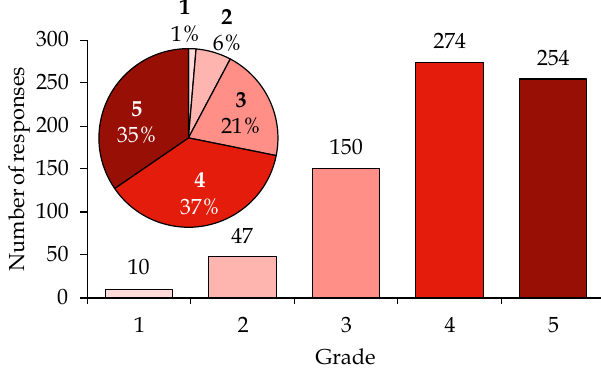
Figure 14. Responses on citizens’ perception of safety of presence in urban green areas in regard to disease transmission (research question: “How safe do you consider the visiting/staying in urban green areas regarding the transmission of diseases?”), (grading scale: 1 = least safe to 5 = most safe).